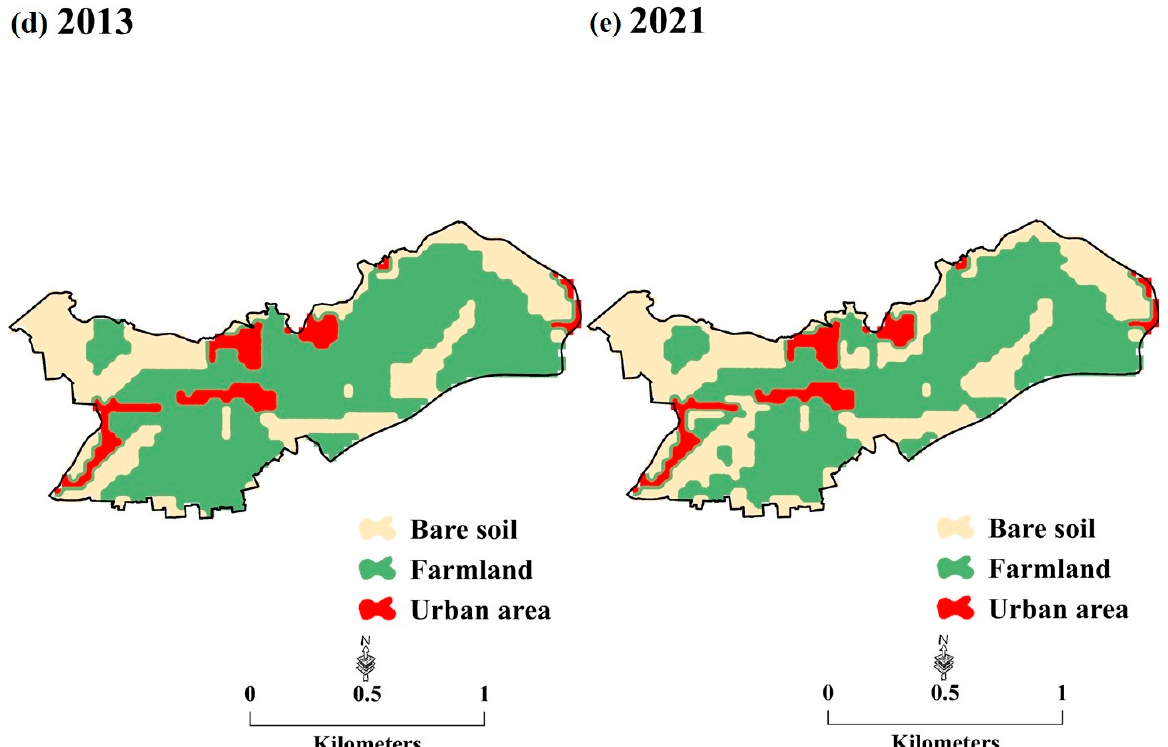
Figure 13. Bare soil (BS), urban area (UA), and farmland LULC classifications in Falaj Al-Khatmeen between 1985–2021.